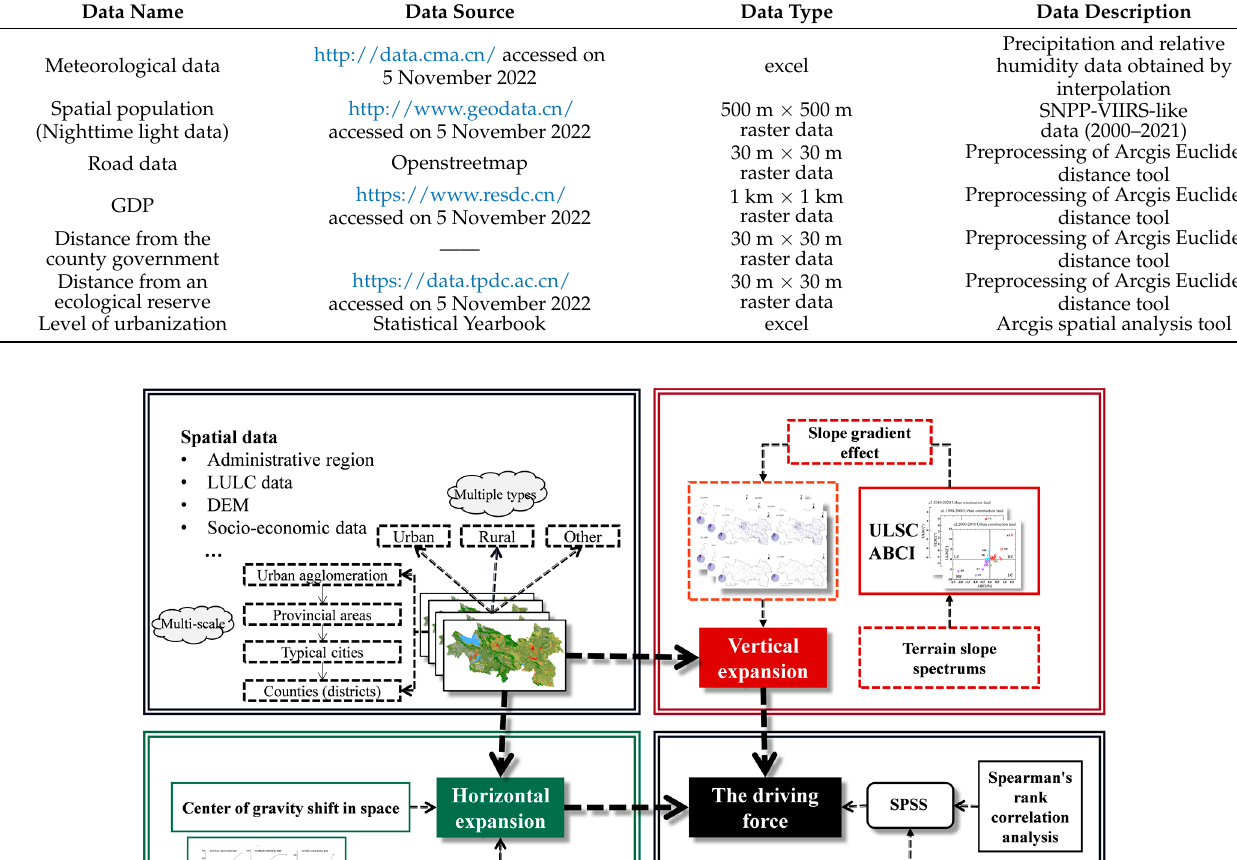
Table 2. Descriptions of the data used in this study.